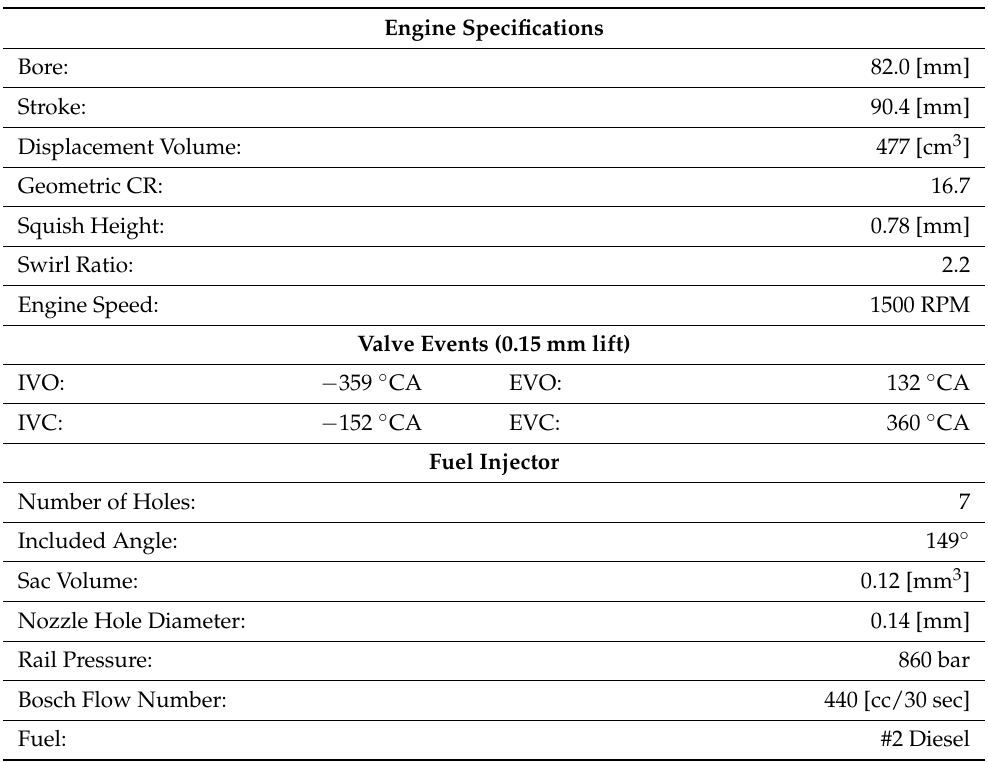
Table 9. Engine and fuel injector specifications